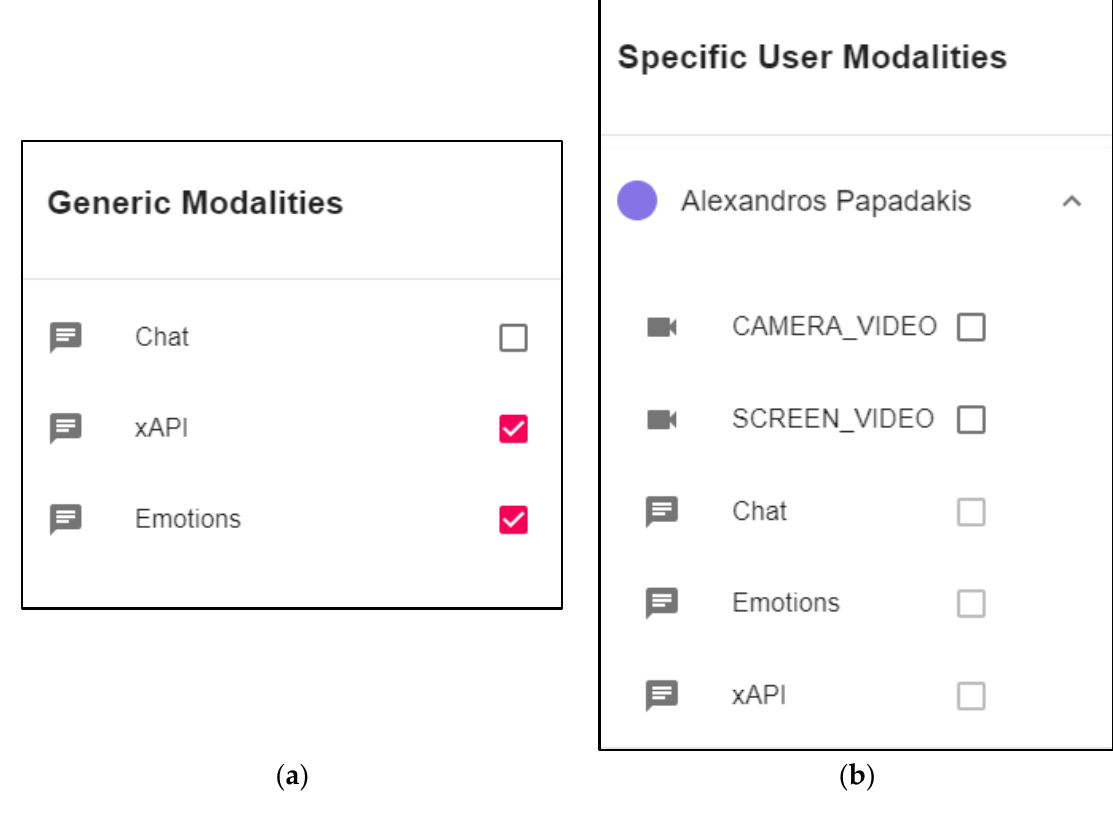
Figure 7. Arion Platform Modalities. ( a ) Generic View modalities; ( b ) User Specific Modalities